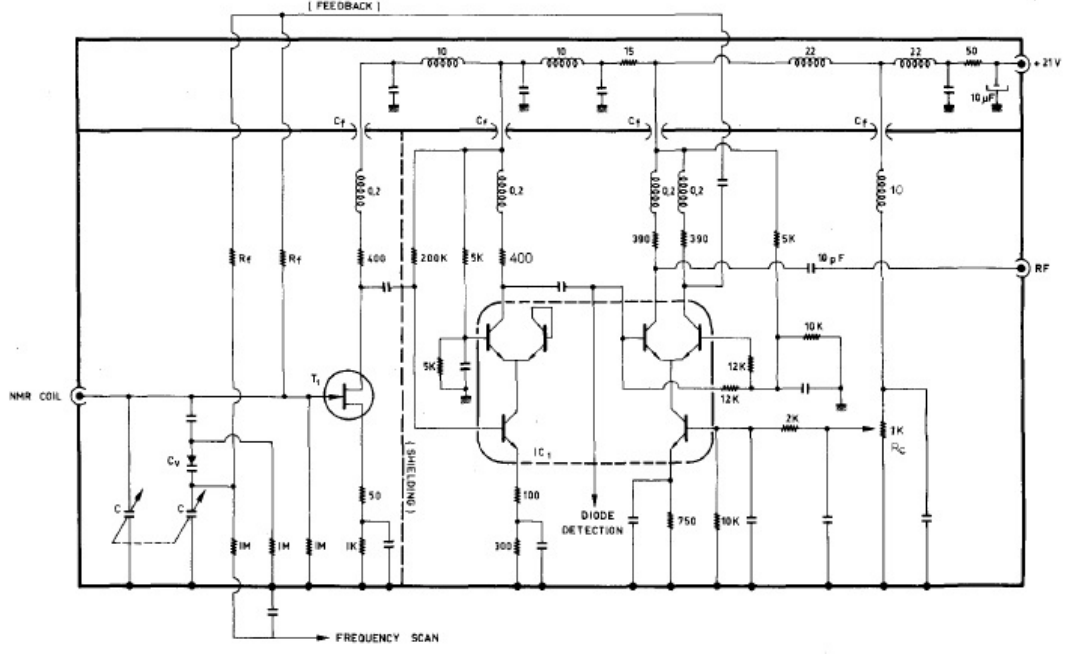
Figure 11. Non-marginal oscillation utilizing the CA3102 chip. (reproduced with permission from [28]. Copyright AIP, 1977).